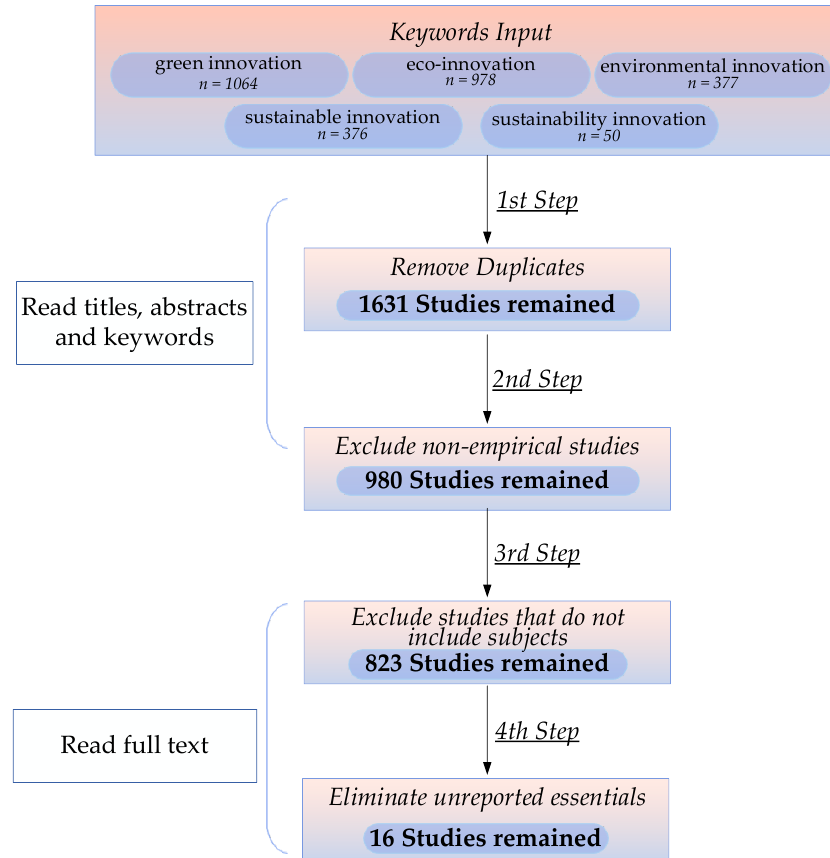
Figure 3. Screening steps for target literature.